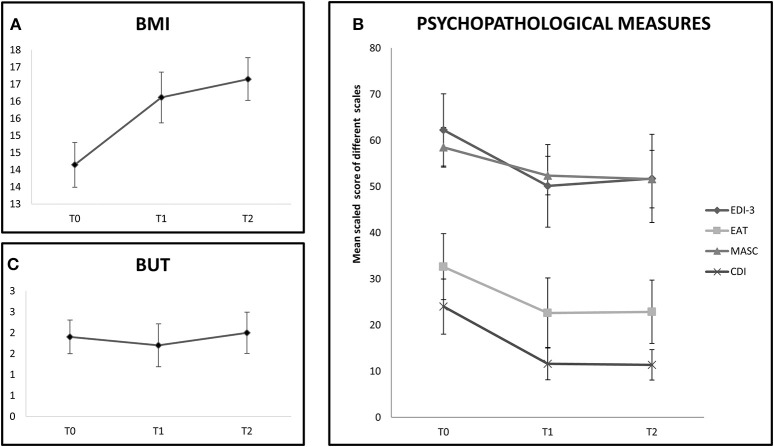
The chart shows follow-up evalution of outcome measures in the tDCS+AU group (only 9 participants). (A) Shows BMI values expressed in mean at baseline (T0), at the end of treatment (T1) and at 1 month follow-up (T2). BMI values increased even at 1-month follow-up. (B) Shows mean scaled score of EDI-III, EAT-26, MASC, and CDI at baseline (T0), at the end of treatment (T1) and at 1 month follow-up (T2). Improvement was stable until 1-month follow-up in the EAT-26, MASC, and CDI scales, but not on EDI-III. (C) Shows mean score of BUT at baseline (T0), at the end of treatment (T1) and at 1 month follow-up (T2). No improvement was shown at any evaluation time.